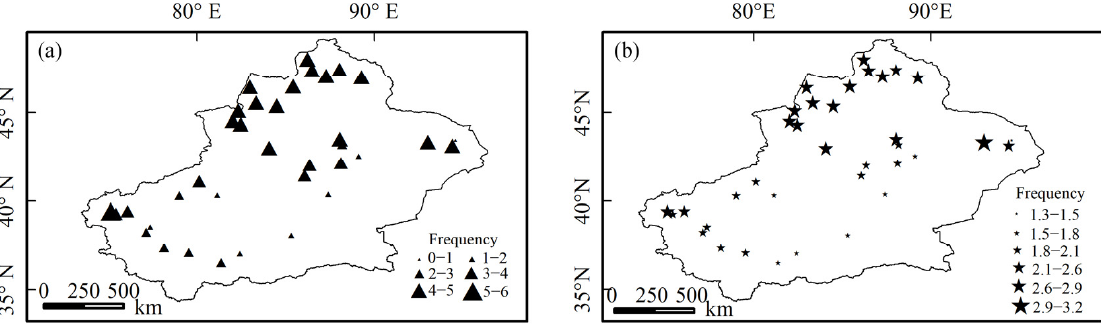
Figure 4. Spatial distribution of annual frequency of extreme dry ( a ) and wet ( b ) events in Xinjiang from 1960 to 2020.